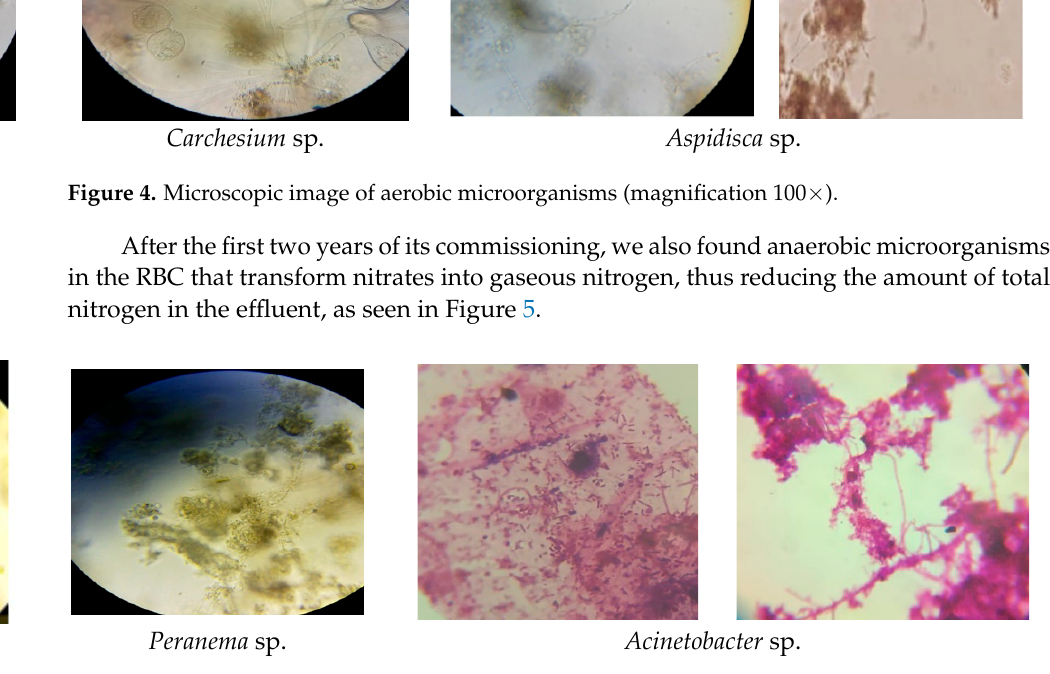
Figure 5. Microscopic image of anaerobic microorganisms (magnification 100×).